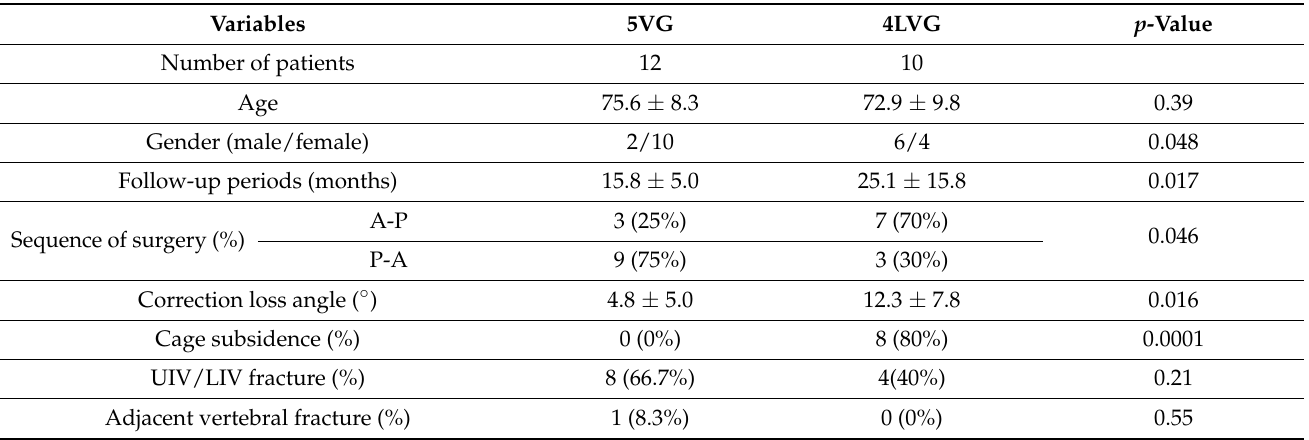
Table 3. Comparison between the five vertebrae fixation group (5VG) and the four or less vertebrae fixation group (4LVG).